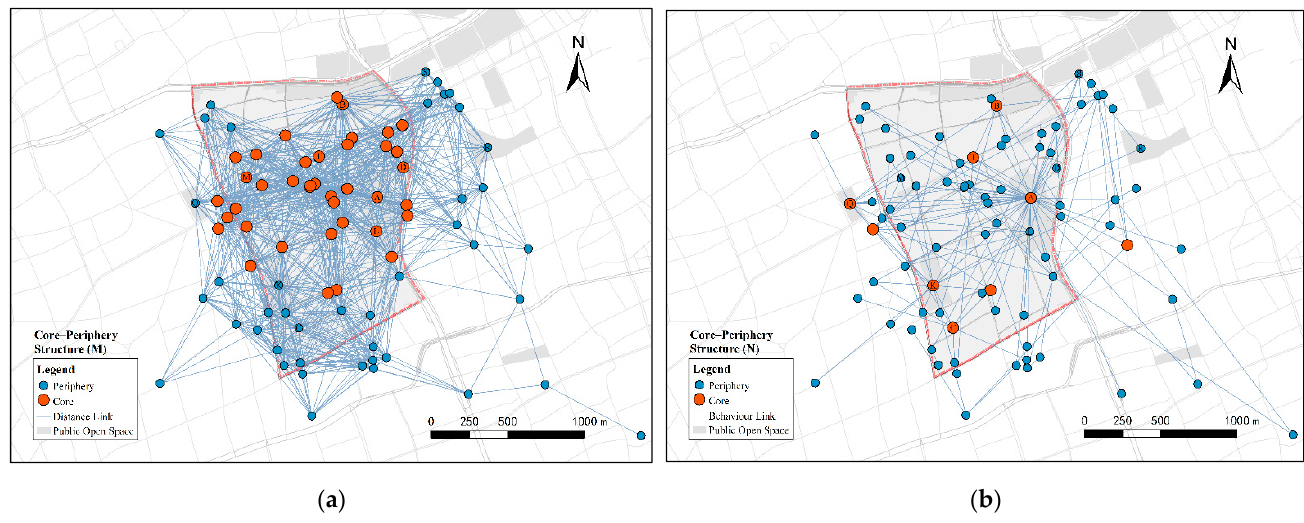
Figure 8. CS of nodes: ( a ) CS in the spatial network; ( b ) CS in the behaviour network.